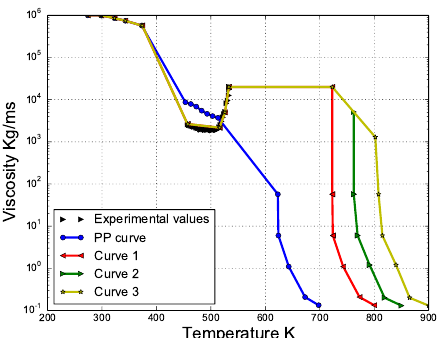
Figure 7. Viscosity